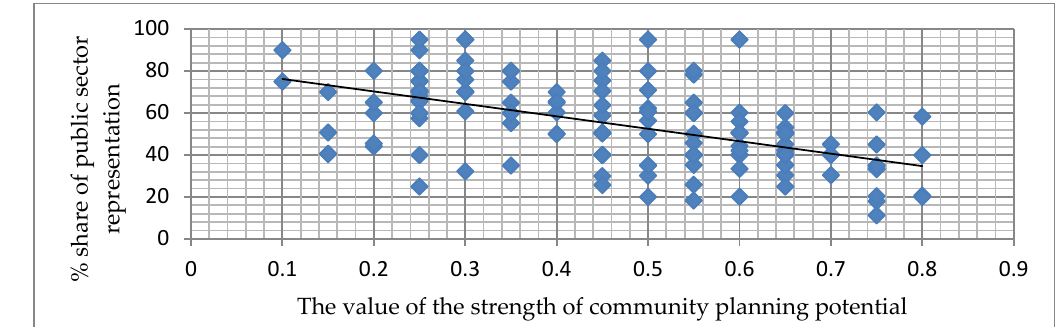
Figure 1. Linear line—the case of public sector impact on the utilization of the Community planning potential. Source: Own processing.